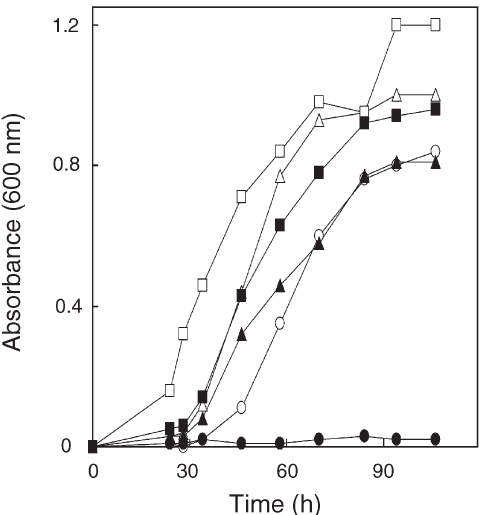
Figure 4. Stimulation of growth of the Δ cbiJ mutant JJ121 by acetate and cobalamin. Growth of wild type in McN ( (cid:2) ), McNA ( (cid:3) ) and McNV ( (cid:4) ) medium. Growth of the mutant JJ121 in McN ( (cid:5) ), McNA ( (cid:6) ) and McNV medium ( (cid:7) ). The inoculum was 4.6 × 10 5 cells that had been grown in McNAYV medium.